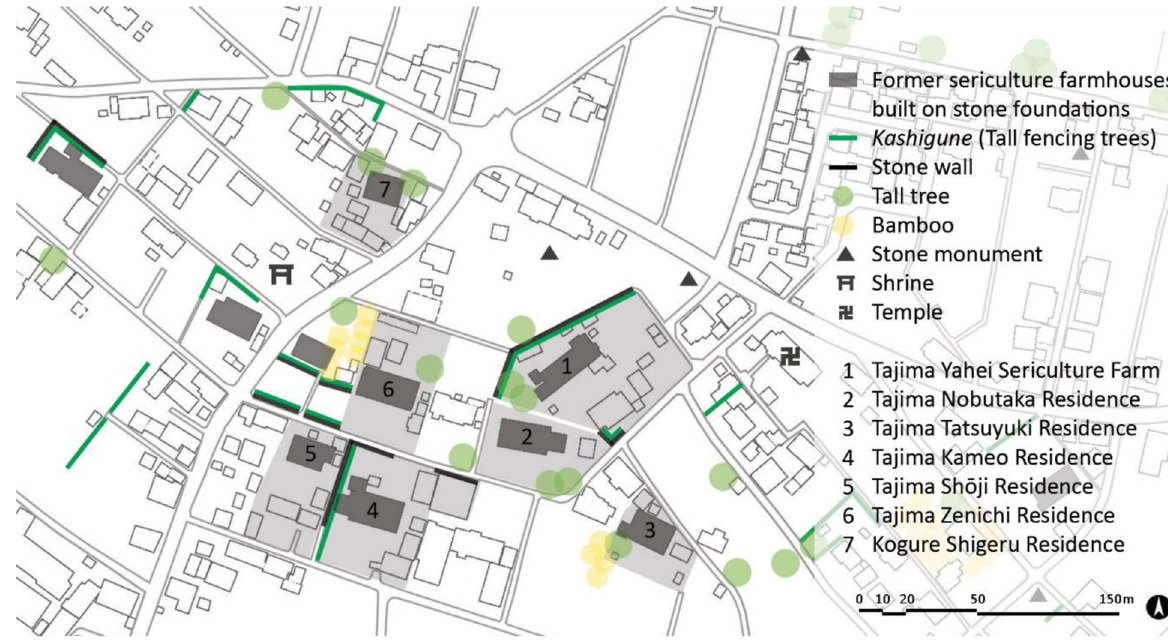
Fig. 10 Tajima Yahei Sericulture Farm and its vicinity. (Source: Sweet Yee